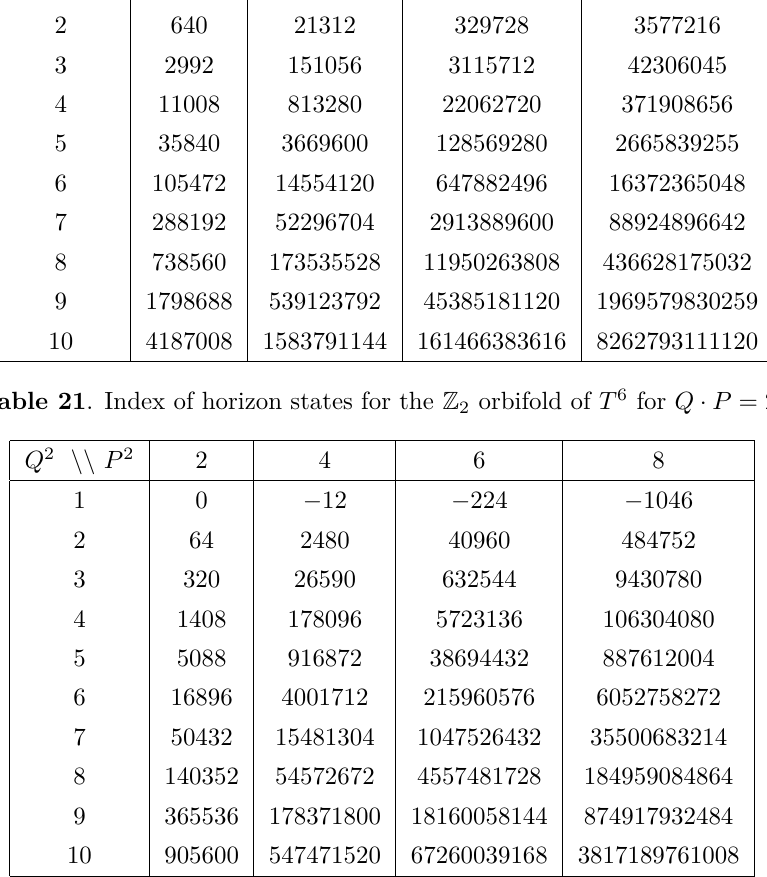
Table 22 . Index of horizon states for the Z 2 orbifold of T 6 for Q · P = 3 . Note that it is only when Q 2 P 2 − ( Q · P ) 2 < 0 we observe that the index is negative.